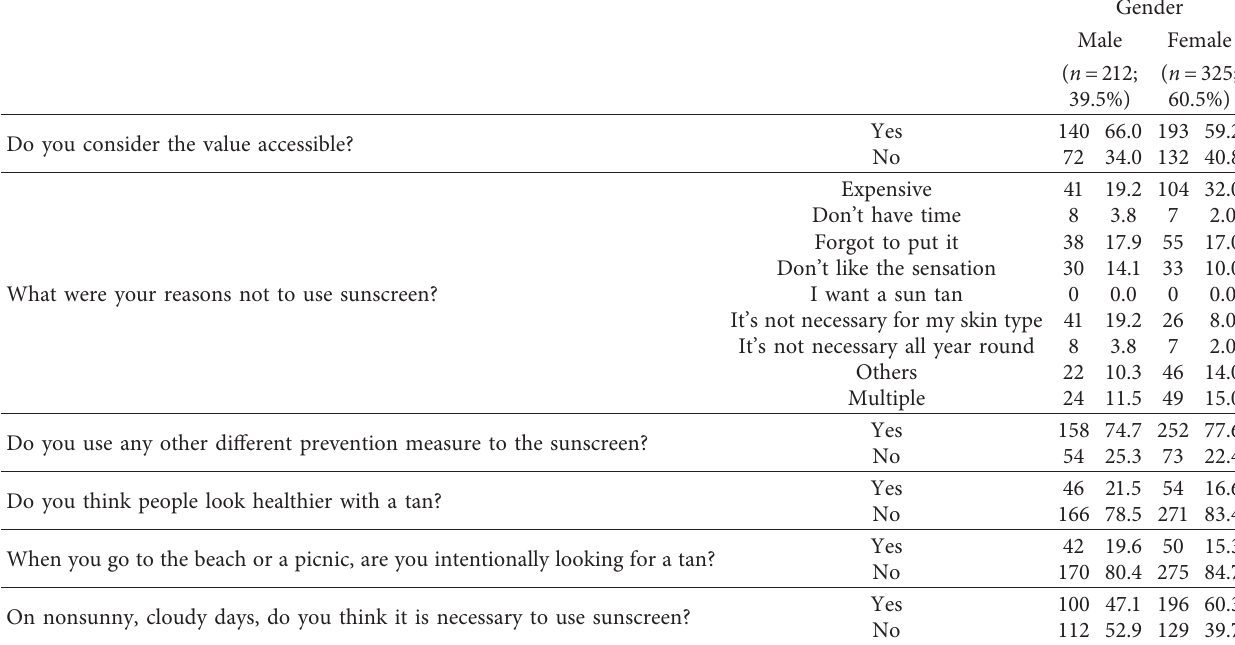
Table 3: Attitude questionnaires of skin cancer.